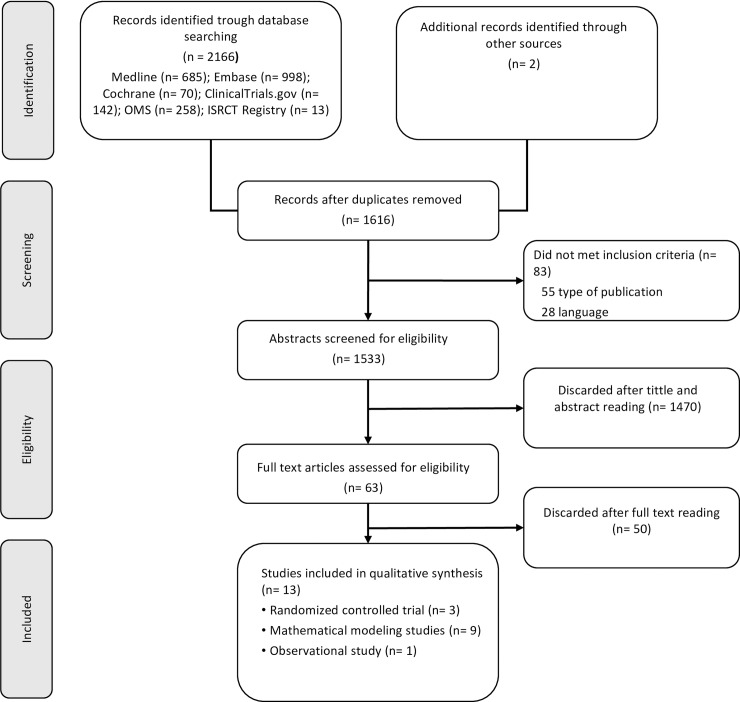
PRISMA flowchart.